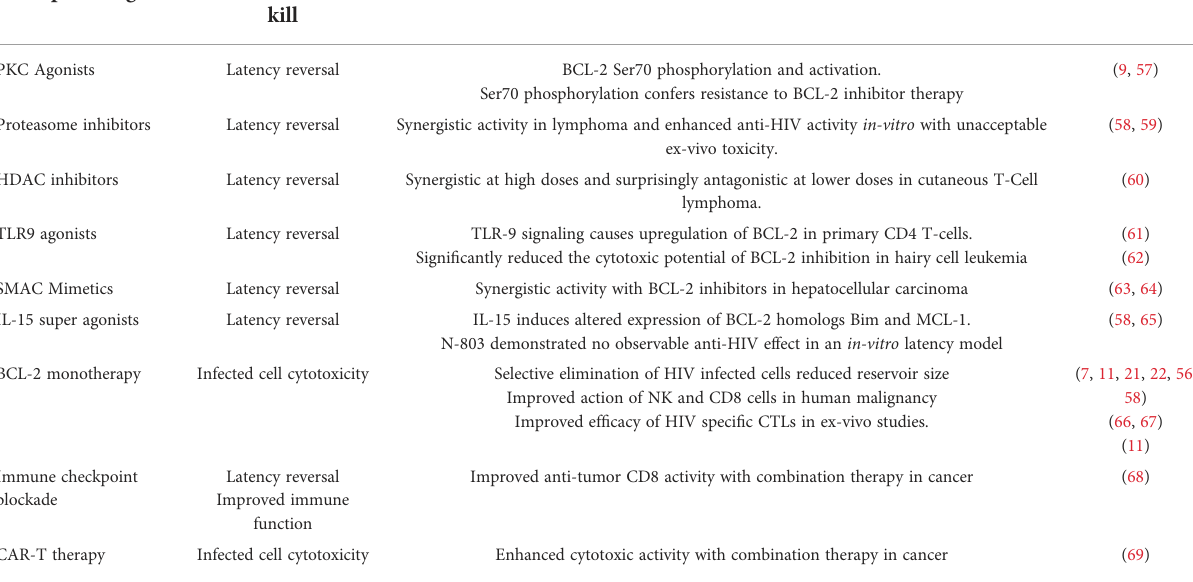
TABLE 1 Shock and kill agents and their interactions with BCL-2 and its